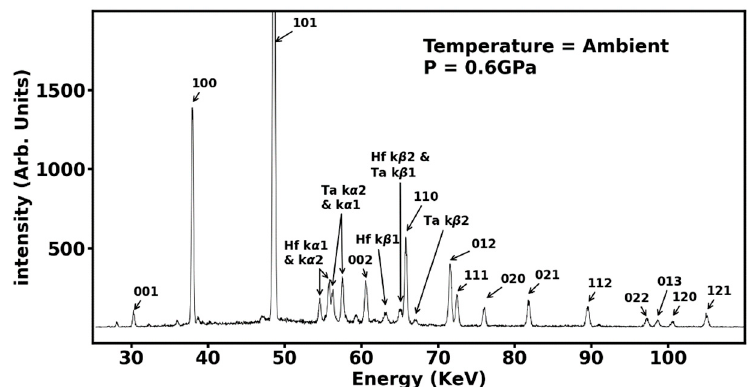
Figure 3 . The synthesized sample of (Hf 0.2 , Mo 0.2 , Nb 0.2 , Ta 0.2 , Zr 0.2 )B 2 at ambient temperature and at a pressure of 0.6 GPa after annealing at 2000 °C for one hour. The fourteen diffraction peaks from the hexagonal AlB 2 -type phase of (Hf 0.2 , Mo 0.2 , Nb 0.2 , Ta 0.2 , Zr 0.2 )B 2 are indexed, indicating completion of the transformation process along with the X-ray fluorescence emission from Hf and Ta.